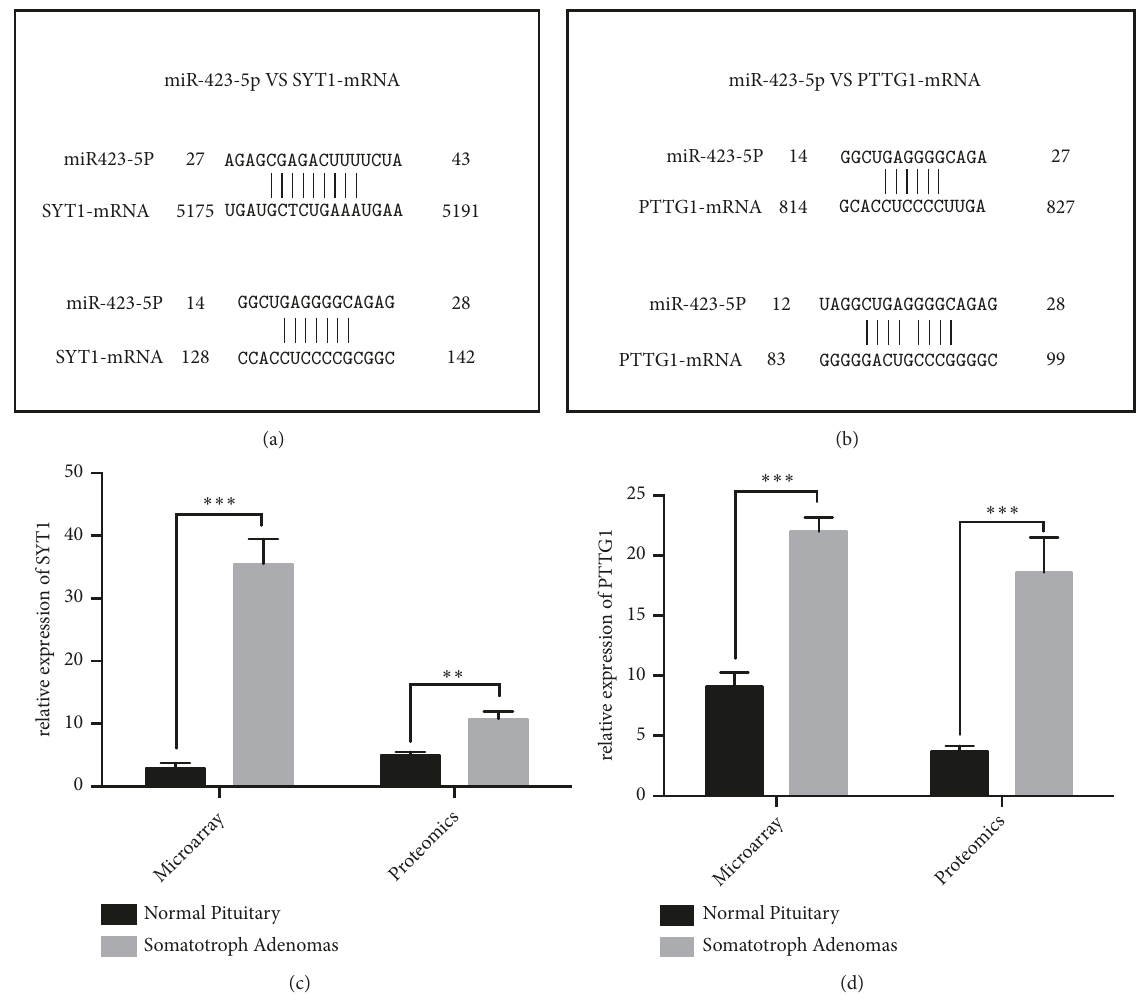
Figure 2: Predicting and validating the expression of miR-423-5ptarget molecules. (a, b): MiR-423-5pinteracting sequences with SYT1 and PTTG1. (c, d): Expression of SYT1 and PTTG1 at the mRNA and protein